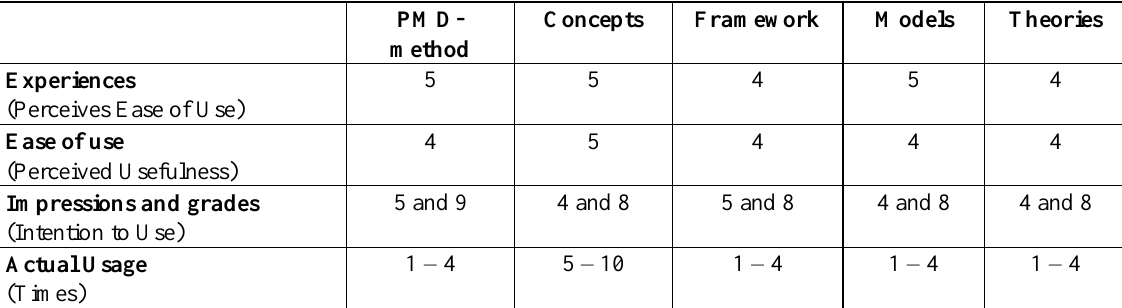
Table 1. Results of combined related questions of survey